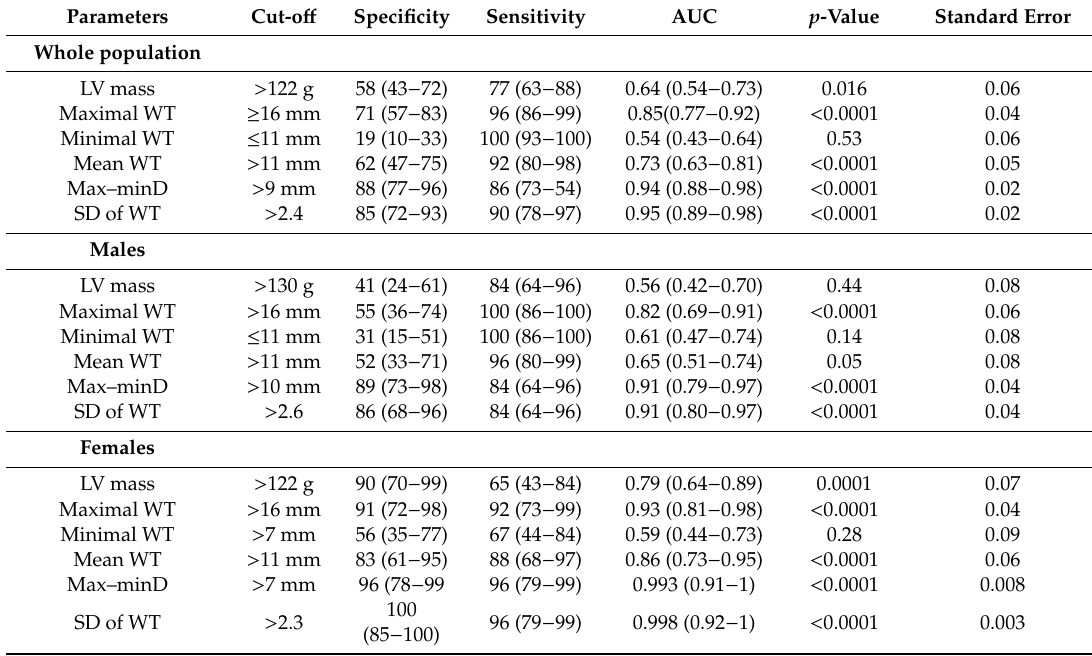
Table 2. Results of ROC curve analysis for distinguishing between HCM and others. Table 2 . Results of ROC curve analysis for distinguishing between HCM and others.